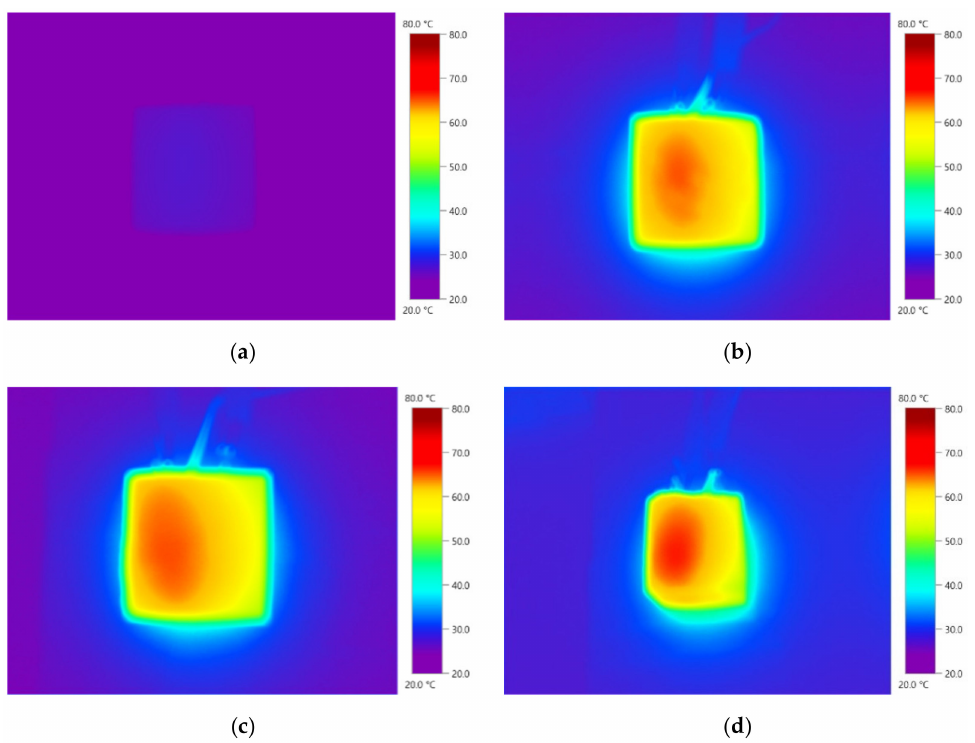
Figure 6. Thermal images of the nanocementitious composites with 0.25 wt% (60 V): ( a ) OPC;